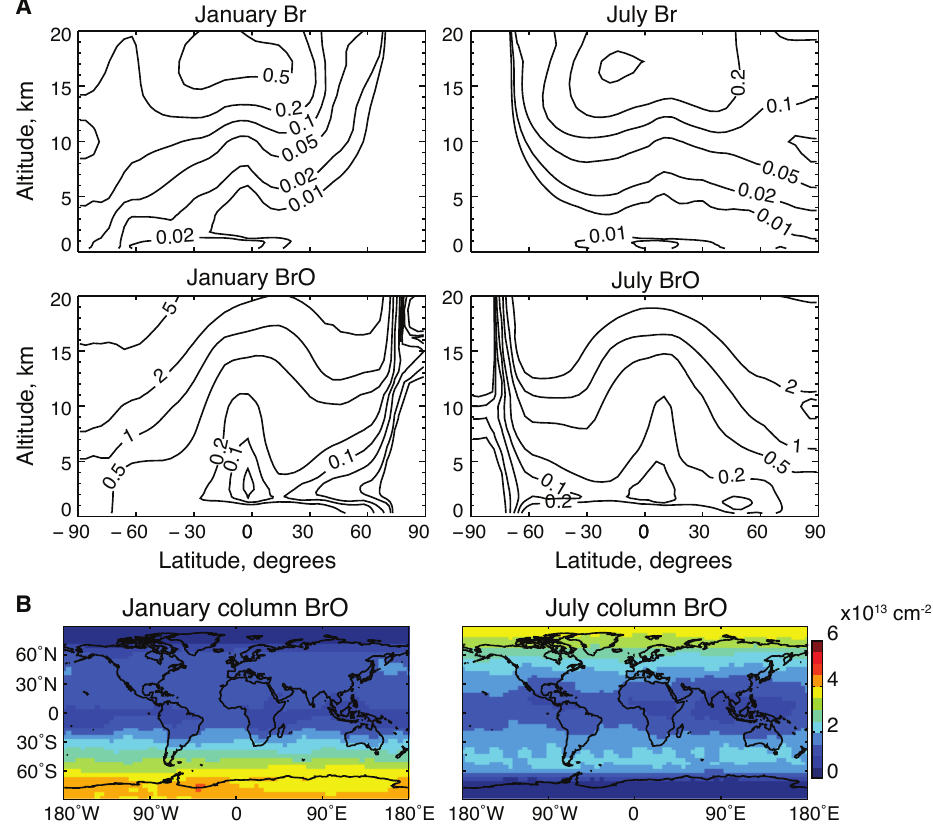
Fig. 2. (A) Zonal mean Br and BrO mixing ratios (ppt) and (B) BrO columns for January and July. Values are 24-h averages in